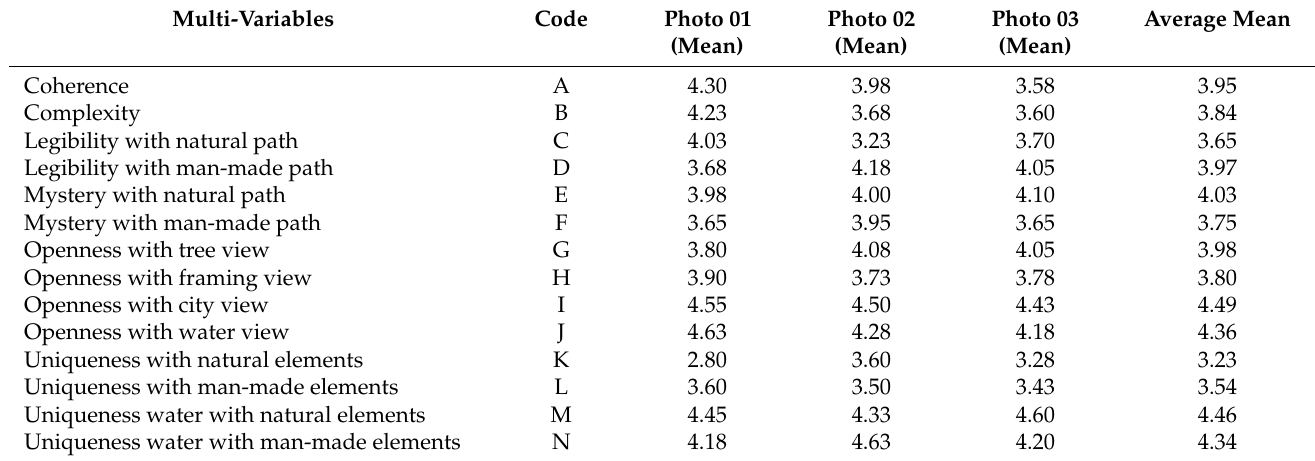
Table 8. Individual mean scores for each photo for assessing the visual aesthetics based on the expert